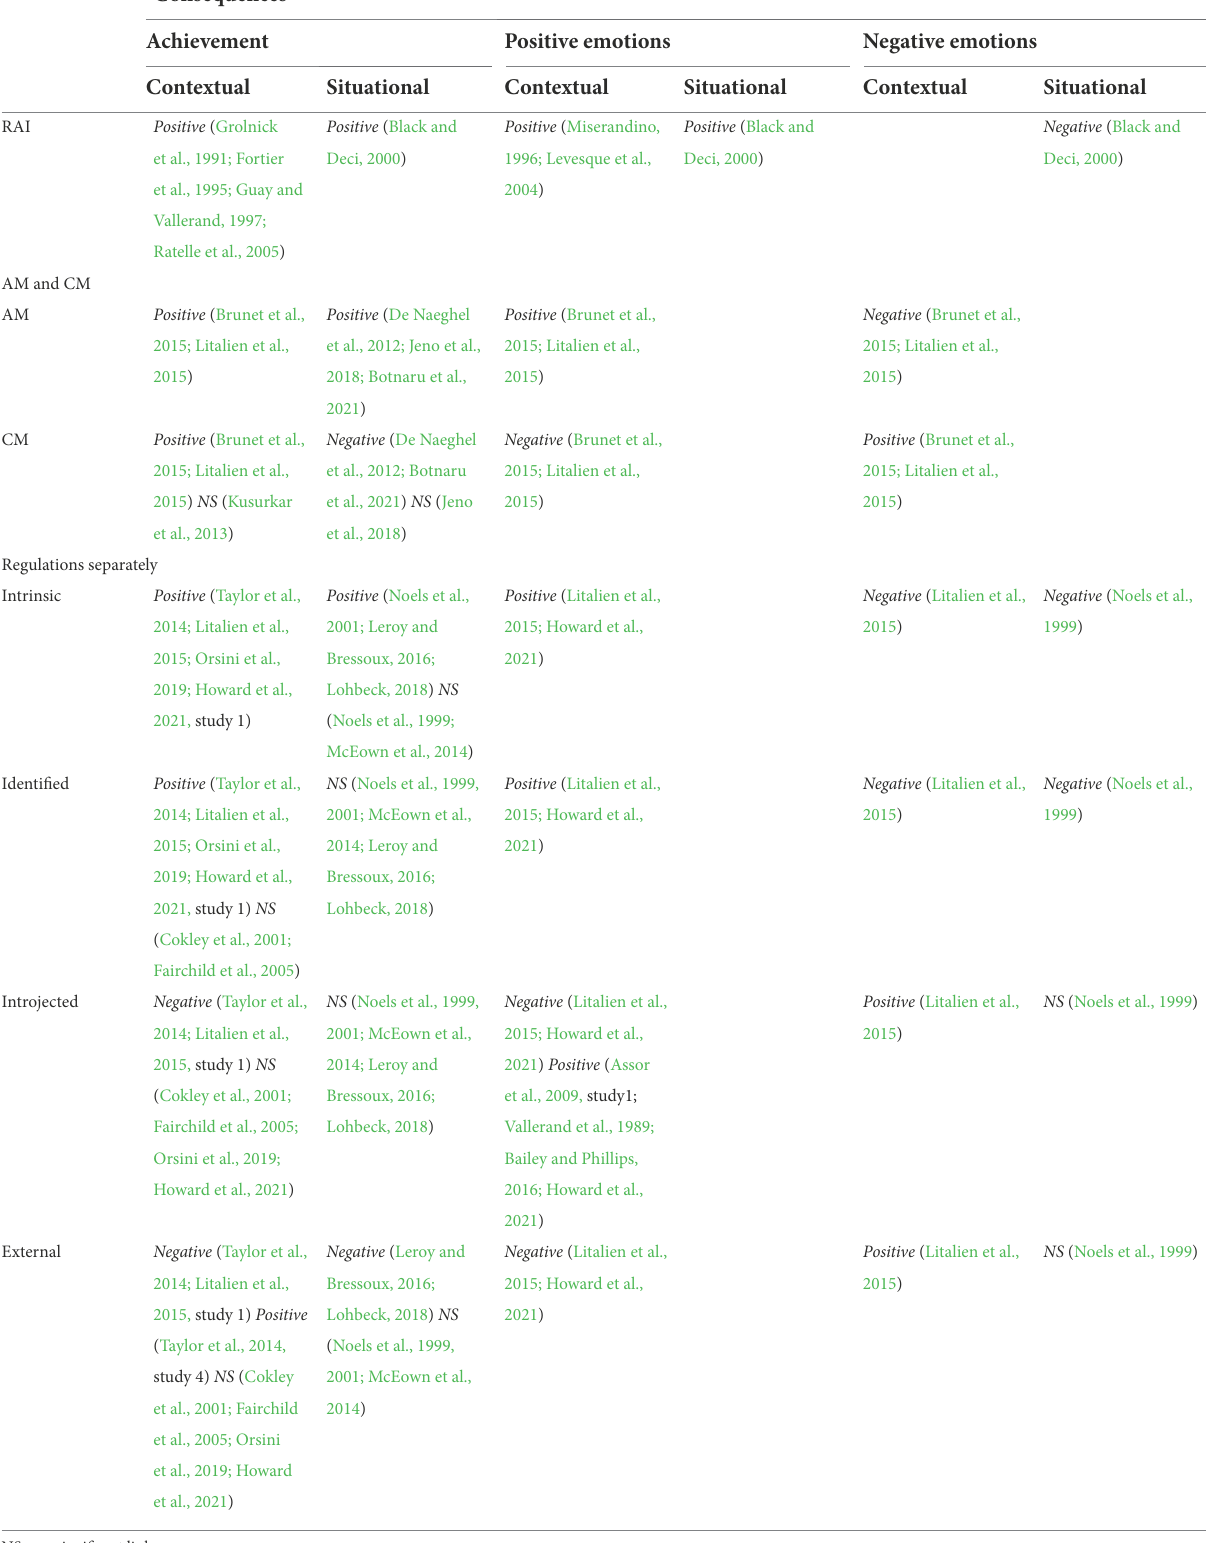
TABLE 2 Synthesis of the links observed in the studies between motivation and its consequences according to the hierarchical level considered and the operationalization of the motivation used. Consequences Achievement Positive emotions Negative emotions Contextual Situational Situational Contextual